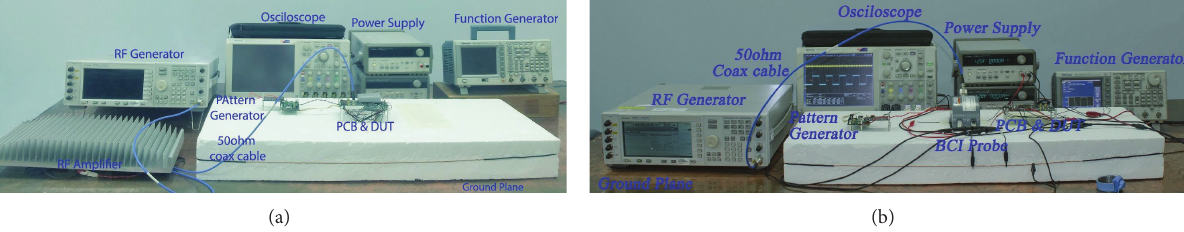
Figure 14: Chip immunity test setup. (a) DPI test. (b) BCI test.